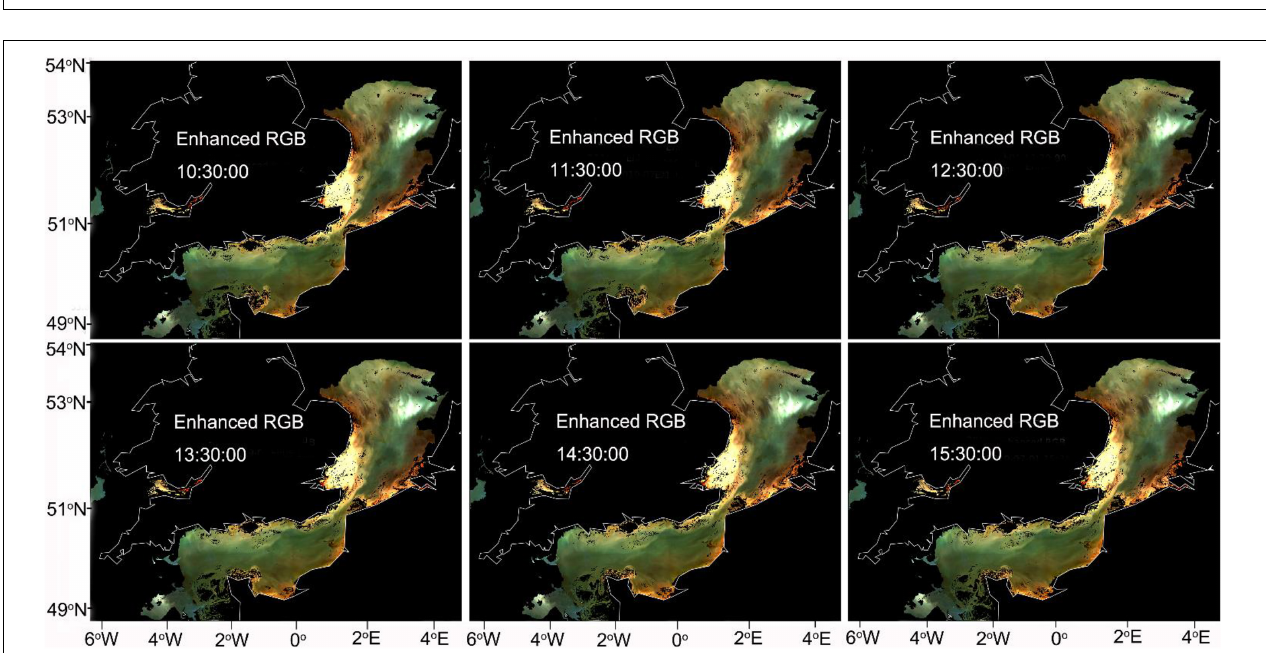
FIGURE 9 | Prediction algorithm applied to the English Channel, June 29 to July 5, 2019: maps showing distribution of predicted Chl at 4-h intervals with high spatial resolution (100 m) (animation: https://rsg.pml.ac.uk/shared_files/junl/paper_animation/example2/chl.gif).